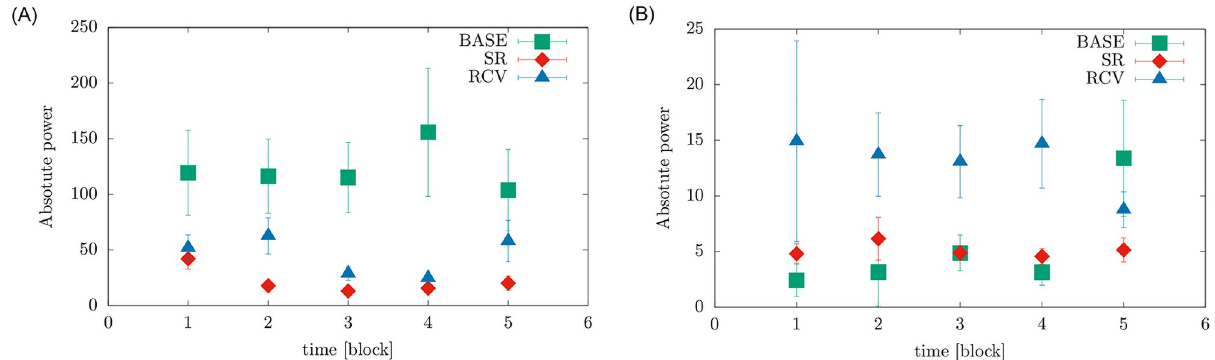
Fig 8. The power spectrum of alpha waves changing in time for resting state with eyes closed (left panel) and eyes open (right panel). Data from electrodes O1 and O2.